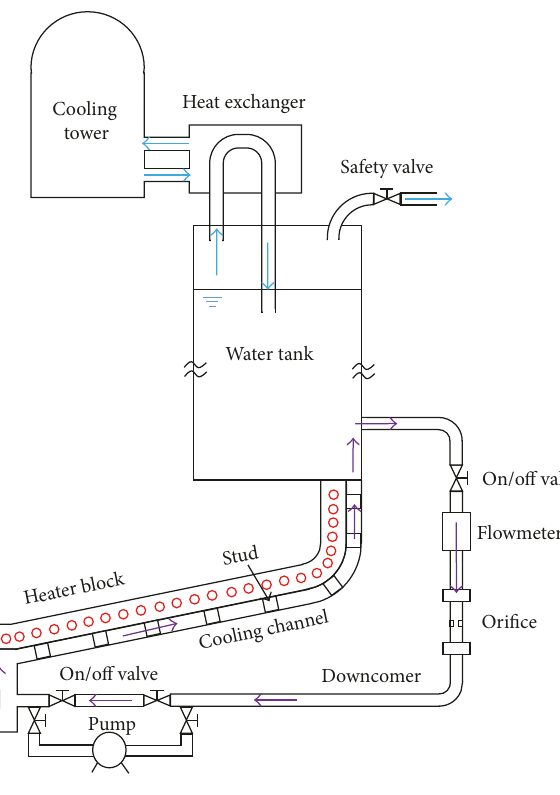
Figure 2: The schematic diagram of the CE-PECS facility.